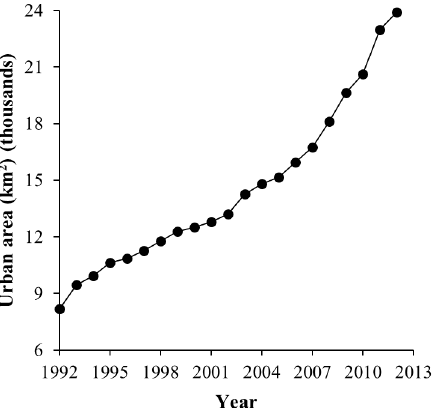
Figure 8. Total urban area (km 2 ) in Saudi Arabia from 1992 to 2013.